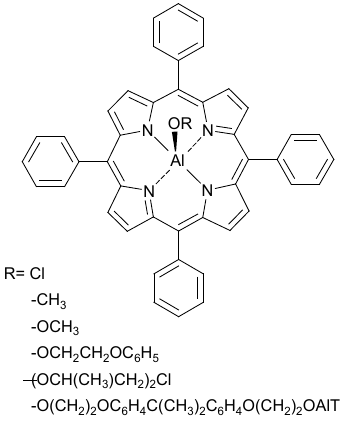
Figure 5. Structure of alkoxide‐aluminum‐tetraphenylporphyrin [21].